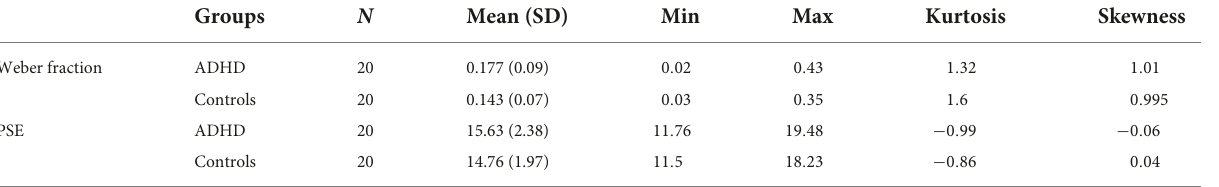
TABLE 1 Descriptive statistics on numerosity perception.